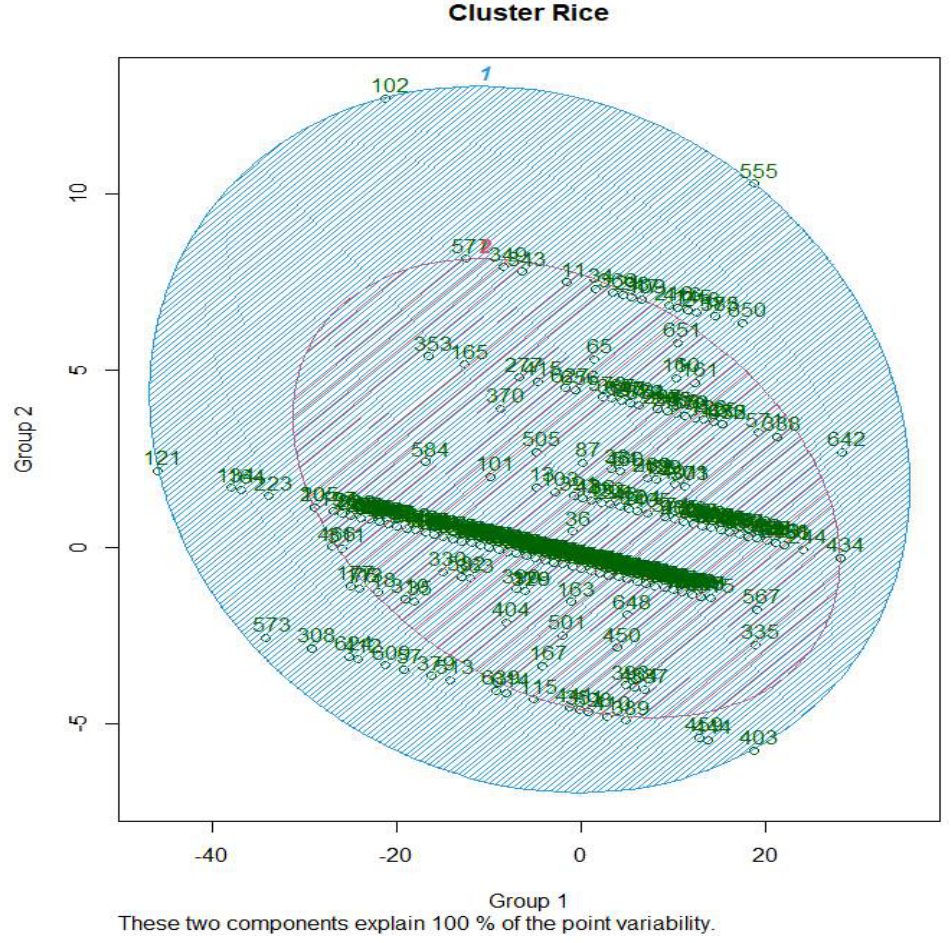
Figure 1. The k −means clustering results. Source: Authors’ estimation. Figure 1. The K-Means clustering results. Source: Authors’